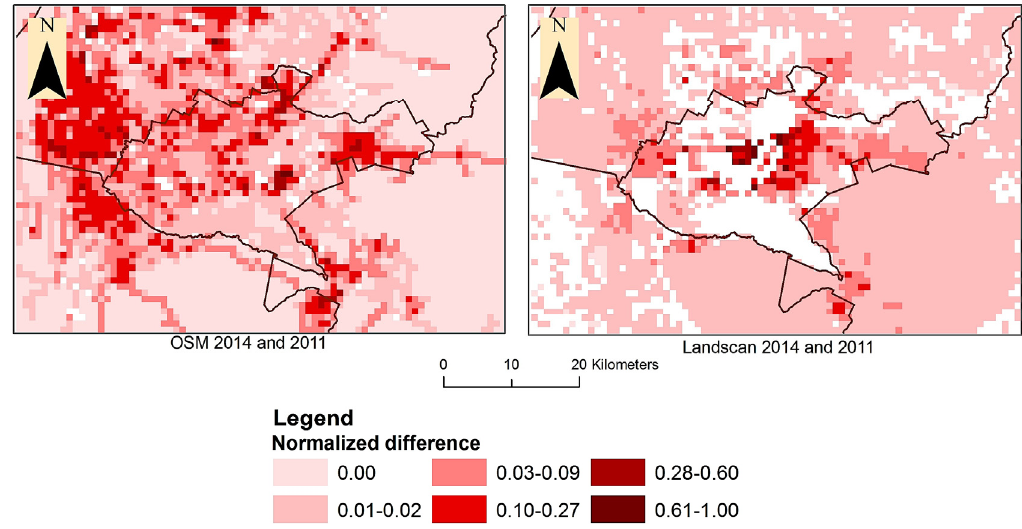
Figure 13. Normalized changes in OSM change vs. population density change due to additions.